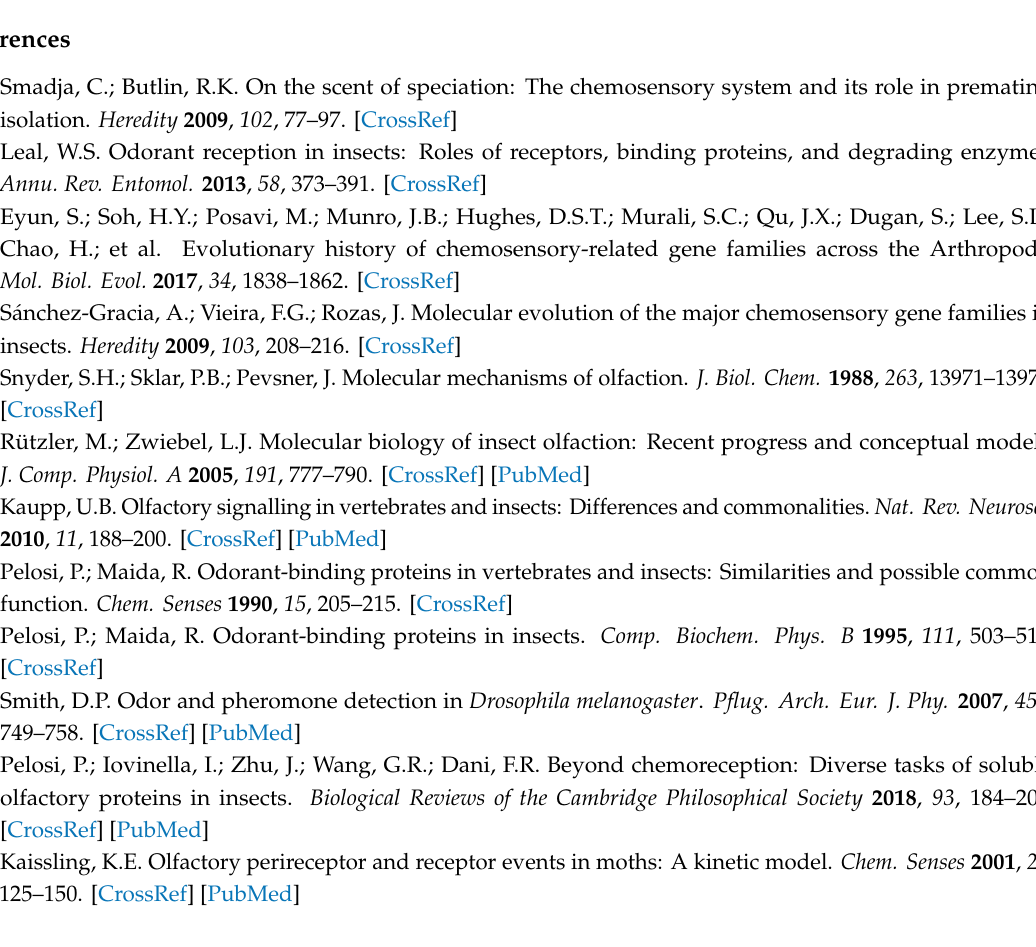
Figure S1: The relative frequency of multiple CSP amino acids sequences corresponding to each position and multiple amino acid sequences alignment analysis of 104 CSP genes. The four conserved cysteine residues were highlighted with yellow shadow. Figure S2: The CAI values of 104 CSP genes clustered by groups in the 11 fig wasps. The abscissa represented the name of the CSP genes. The ordinate represented the CAI values. The seven CSP groups were distinguished by di ff erent colors, the same colors as the seven groups in Figure 1. Table S1: Features of CSP genes identified in the 11 fig